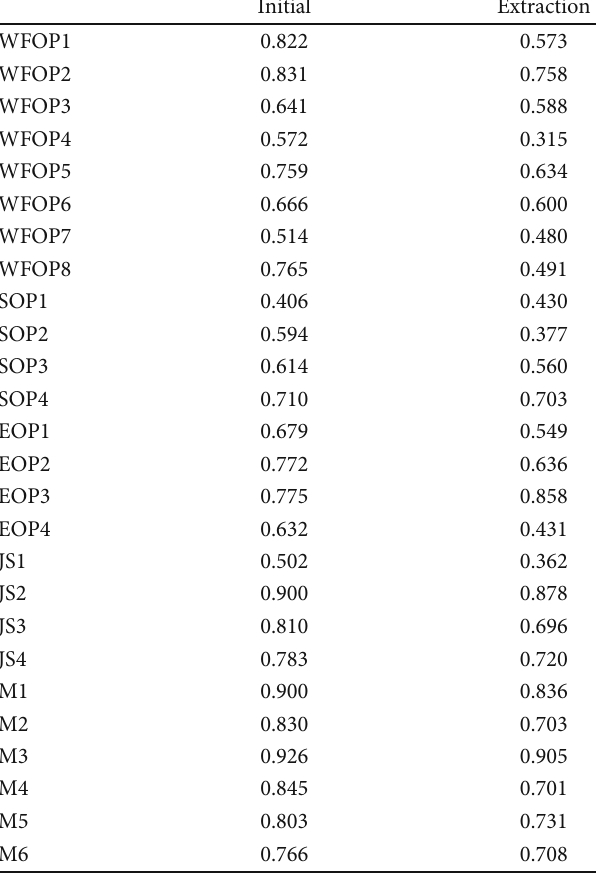
Table 4: Communalities.